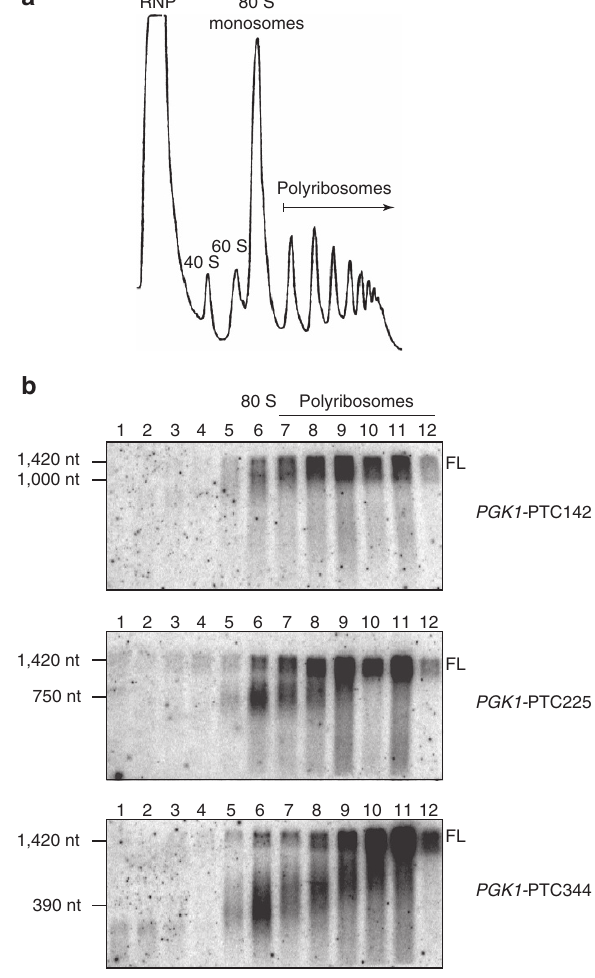
Figure 3 | 3 0 RNA decay fragments are ribosome bound. ( a ) Ultraviolet absorbance trace from polyribosome analysis of cells expressing ATPase- deficient UPF1 and one of three PTC-containing PGK1 reporter mRNAs; ribosome-free RNA (RNP), 40S, 60S and 80S ribosomal subunits, and polyribosomes are indicated. ( b ) Northern blot analysis of PTC-containing PGK1 reporter mRNA from each gradient fraction. Full-length reporter mRNA (FL) is indicated. Results are representative of three independent experiments. Nt, nucleotide.